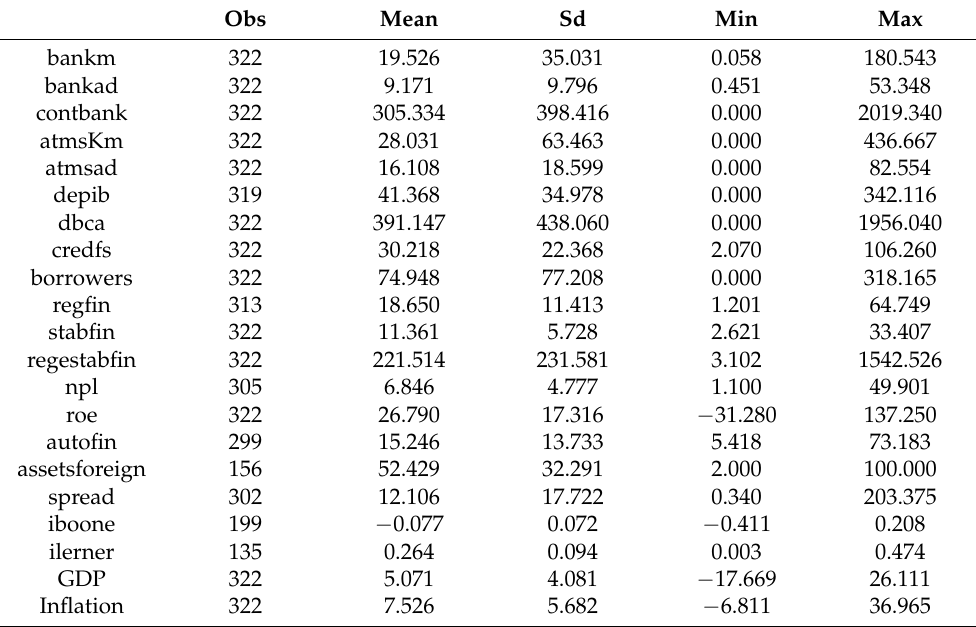
Table A2. Descriptive statistics of the full